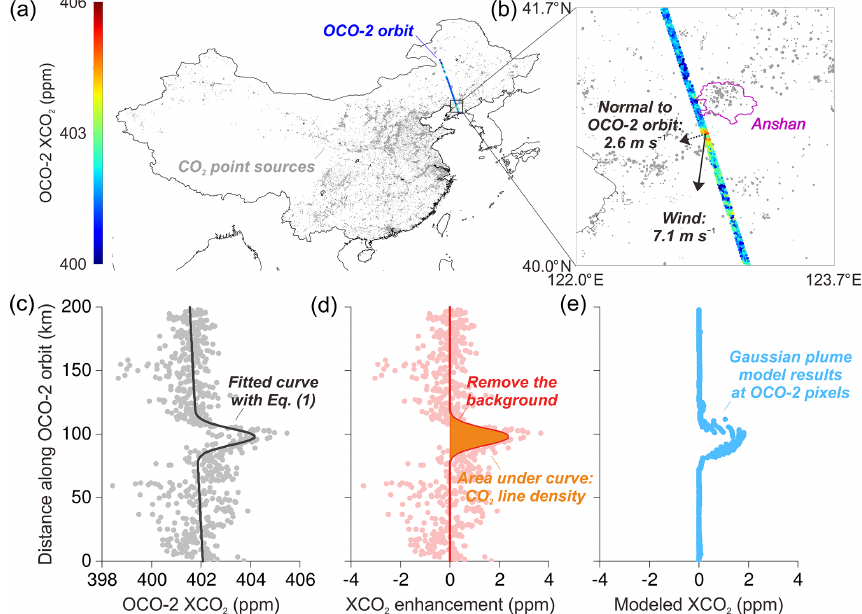
Figure 2. Quantification of CO 2 emissions from Anshan. (a) The OCO-2 orbit on 17 October 2016 is plotted on the map of MEIC emission point sources. (b) Zoom in closer to see OCO-2 XCO 2 data, local wind speed, and wind direction. The width of the track is made of eight cross-track OCO-2 footprints. (c) The valid XCO 2 data points (grey dots) plotted along the OCO-2 orbit with a fitted curve (black) based on Eq. (1). (d) The XCO 2 enhancement (red dots) above background, the fitted curve (red), and the area under the curve (orange shade). (e) The modeled XCO 2 enhancement (blue dots) by the Gaussian plume model combined with the MEIC emission